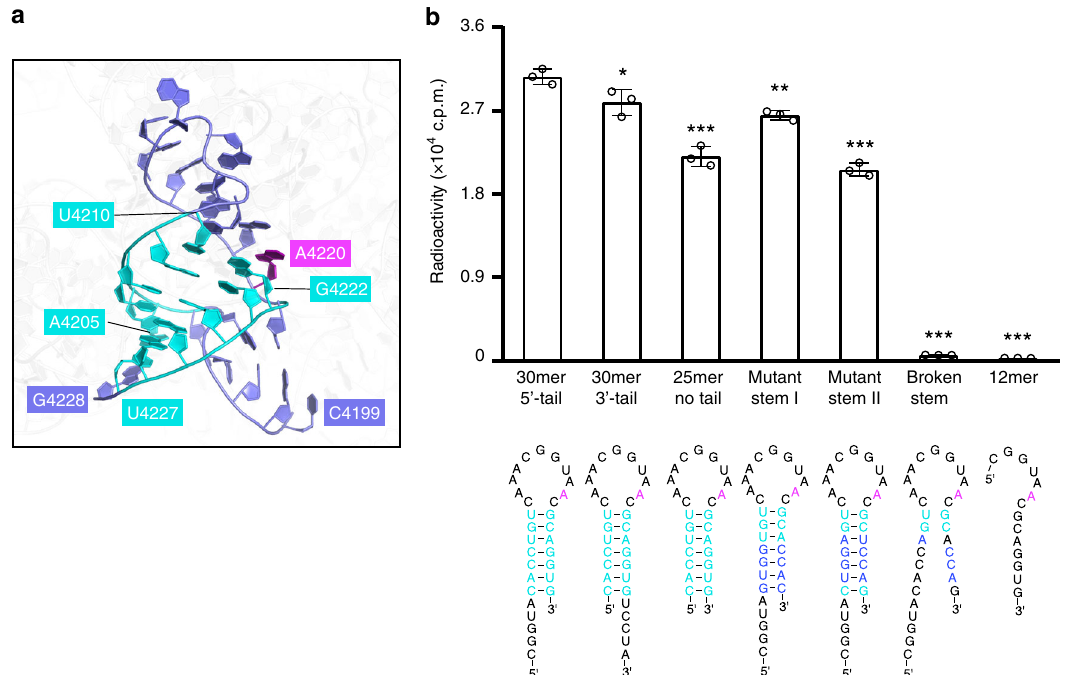
Fig. 3 Substrate speci fi city of ZCCHC4. a The cryo-EM structure of 28S rRNA (PDB 4UG0 [https://www.rcsb.org/structure/4UG0]) highlighting the local conformation of the 30-mer RNA substrate used in this study. The stem nucleotides are colored cyan. Target Ade4220 and the rest of 30-mer RNA are colored magenta and slate, respectively. Other regions of the 28S rRNA are colored gray in transparent view. b Methylation activity of ZCCHC4 on the indicated RNA substrates, with the corresponding schematics shown beneath. The data are mean ± SD. Statistical analysis used two-tailed Student ’ s t test for the difference from native 30-mer RNA with 5 ′ -tail: * p < 0.05; ** p < 0.01; *** p < 0.001. Source data are provided as a Source Data fi